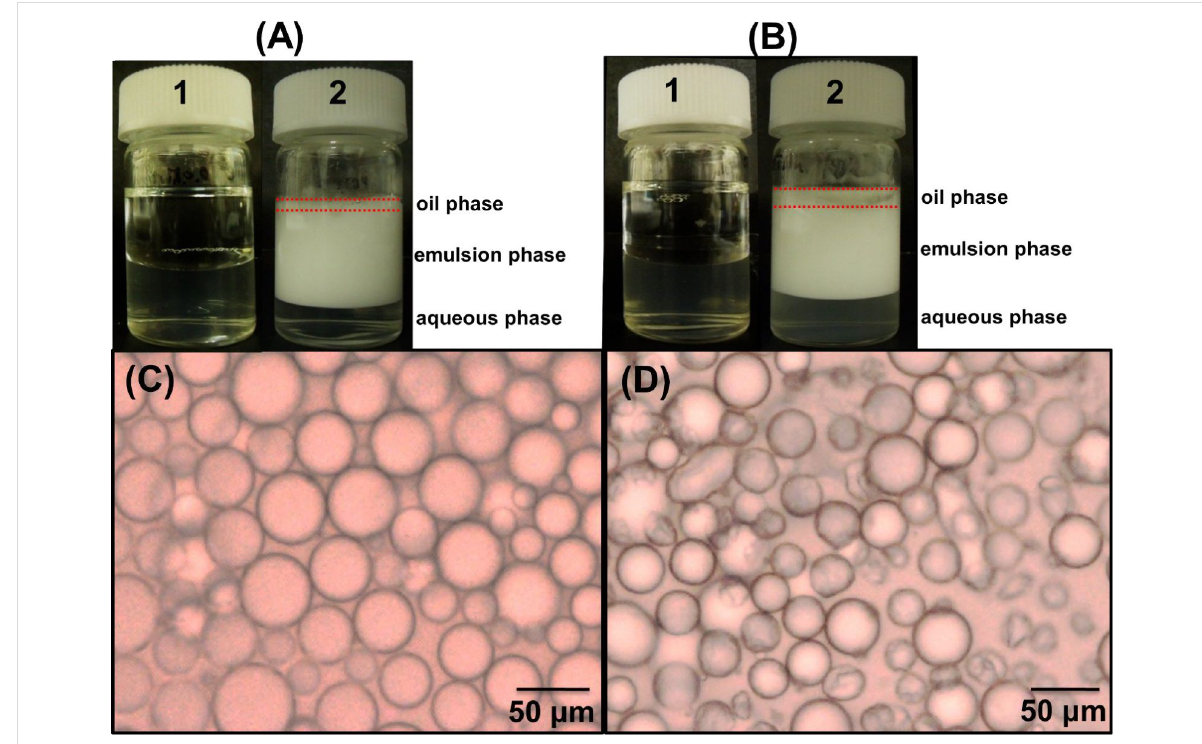
Figure 4: (A,B) Digital photograhs of (1) the initial DM- β -CD/PDI nanogel (0.1 wt %) with (A) n -dodecane or (B) toluene added directly to the vial and (2) the n -dodecane- or toluene-in-water emulsion stabilized by the DM- β -CD/PDI nanogel after standing for 24 h. Red dotted lines show oil phase boundaries. (C,D) The corresponding optical microscope image for the (C) n -dodecane- or (D) toluene-in-water droplets stabilized with the DM- β -CD/ PDI